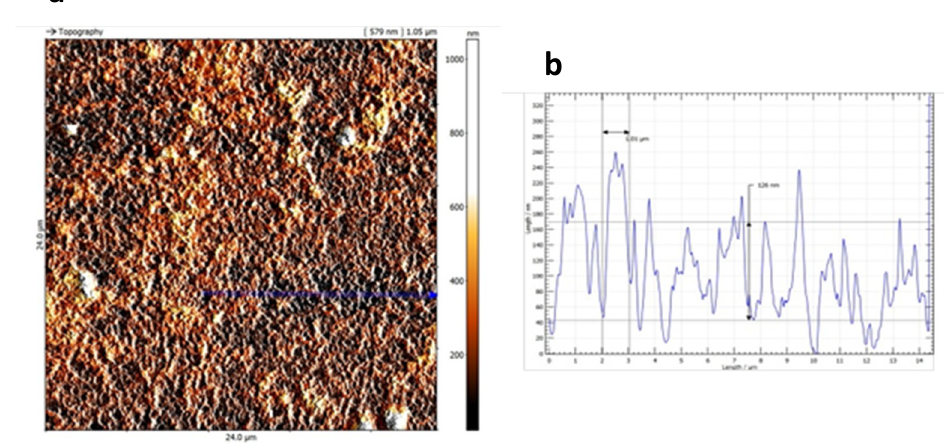
Figure 3. Atomic force microscopy (AFM) topographical image ( a ) and surface roughness profile ( b ) of an AuNP layer electrochemically deposited on a glassy carbon plate correspondent to the blue line present in Figure 3a.